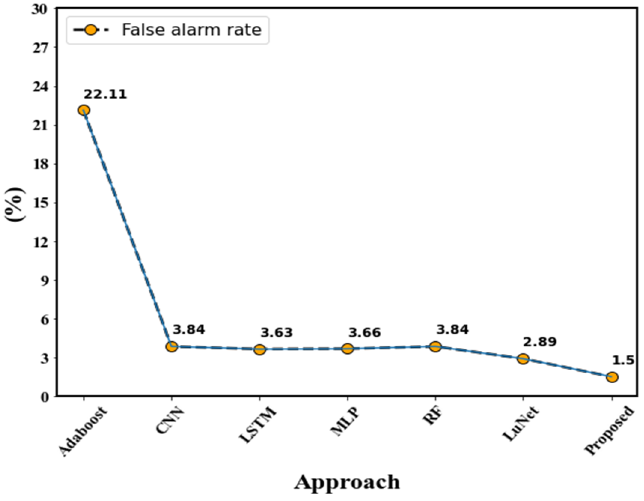
Figure 12. Proposed vs. existing FAR comparison.